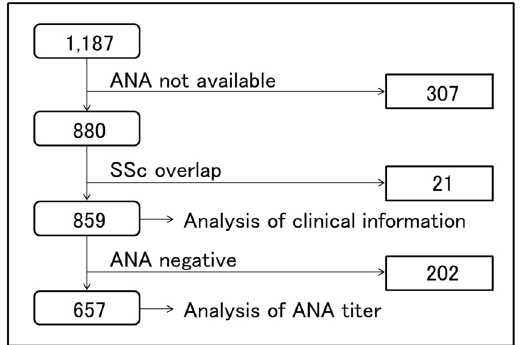
Figure 2. A flow chart of study participants with RA in the KURAMA cohort. From 1,187 RA patients, 307 patients without ANA data were excluded. Then we excluded 21 patients overlapping with SSc. The remaining 859 patients were used to compare ACA-positive patients with ACA-negative patients. We analyzed 657 subjects positive for ANA to compare the level of ANA among each staining